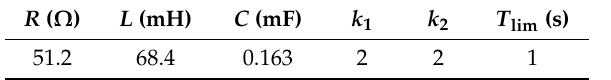
Table 2. Parameters used in the experiment.